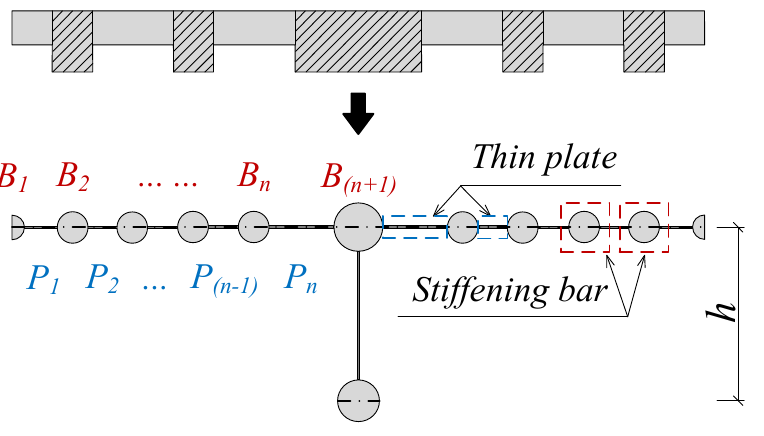
Figure 4. Dividing stiffeners and thin plates.